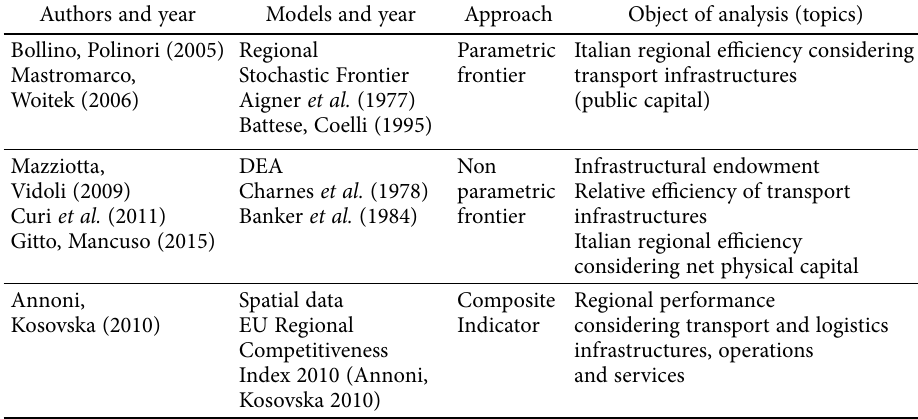
Table 1. Summary of territorial analysis approaches Authors and